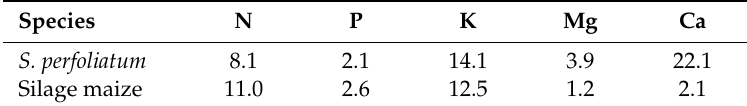
Table 5. Mean concentration of five nutrients (g kg − 1 DM) of harvested S. perfoliatum in comparison to silage maize